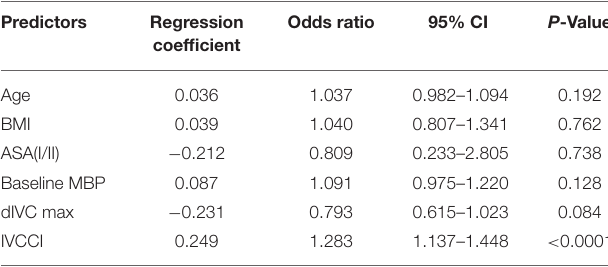
TABLE 2 | Multivariable logistic regression analysis of 90 patients for postspinal anesthesia